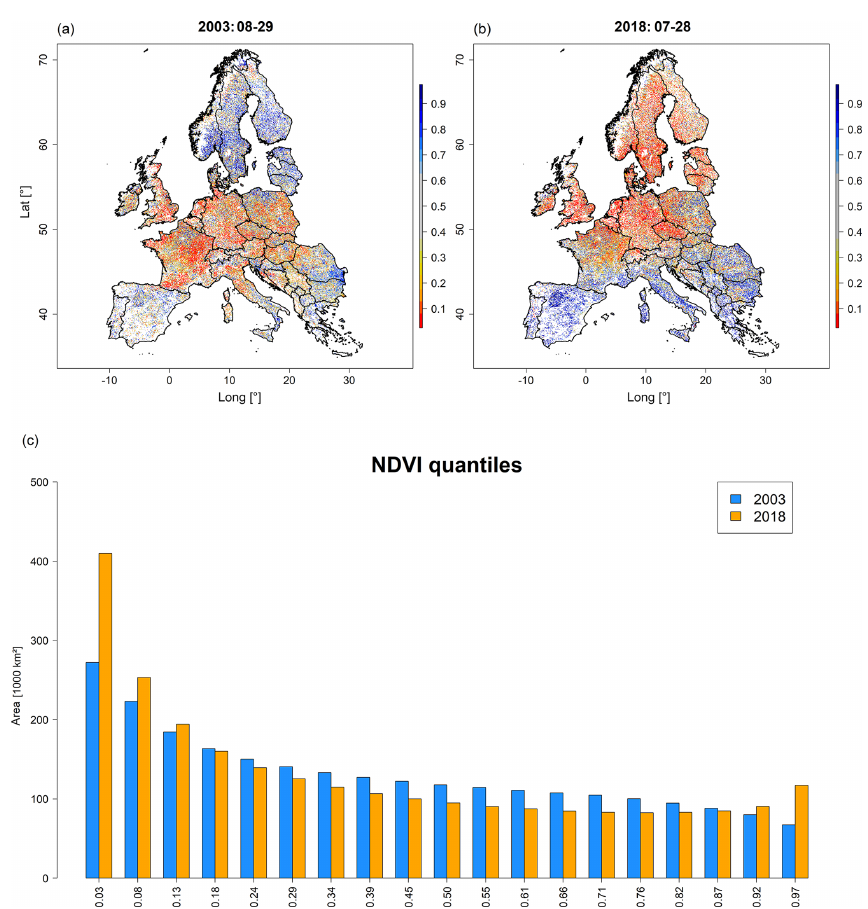
Figure 4. MODIS NDVI quantiles representing peak of drought conditions at the end of August (DOY 241) in 2003 (a) and end of July (DOY 209) in 2018 (b) for the five selected land cover types as well as the corresponding area histograms (in units of thousands of square kilometres) representing the 19 NDVI quantiles (c) . Shades of blue in (a) and (b) indicate upper quantiles (thus a higher-than-average vegetation greenness), while shades of orange to red indicate lower anomalies (i.e. lower-than-average vegetation greenness). Blue bars in (c) refer to 2003 and orange bars to 2018. Complementary results for MODIS EVI are shown in Fig. S7. Videos depicting the spatio-temporal development of NDVI and EVI are shown in Videos V3 and V4 (http://doi.org/10.5446/44029 and